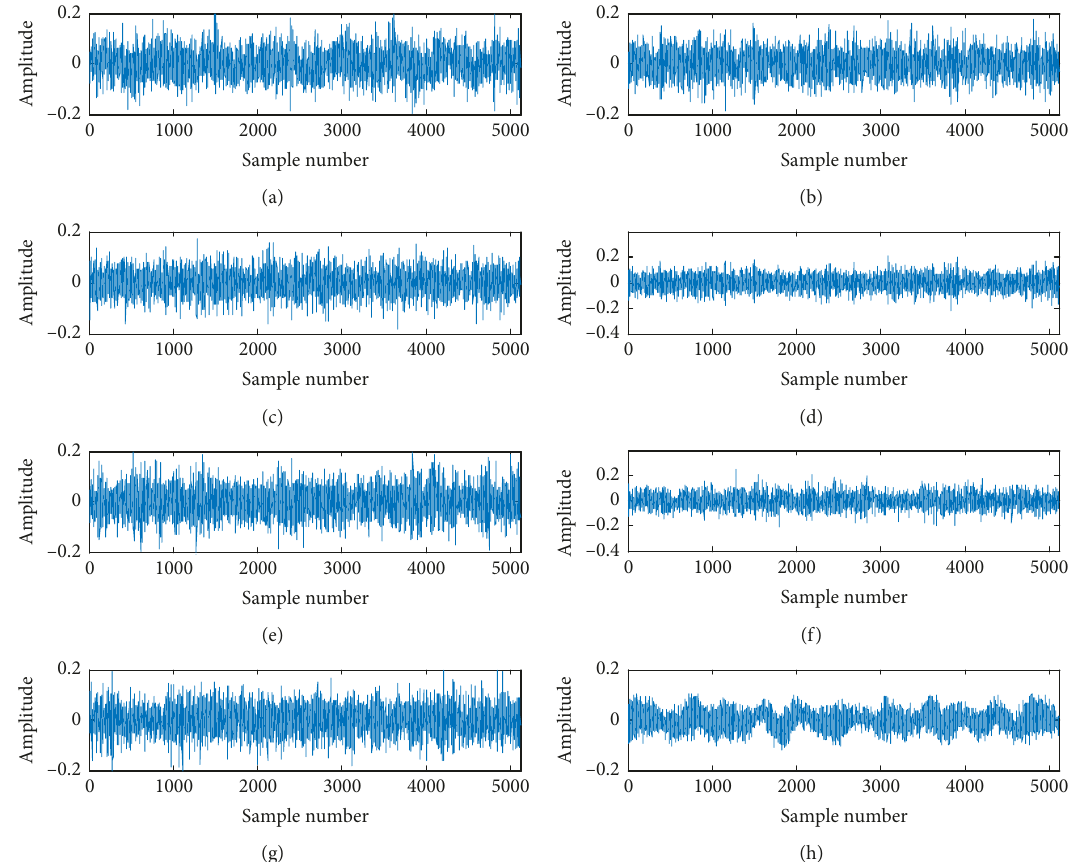
Figure 19: Multiresolution DMD modes of roller bearing’s outer race fault signal (NASA, snapshot